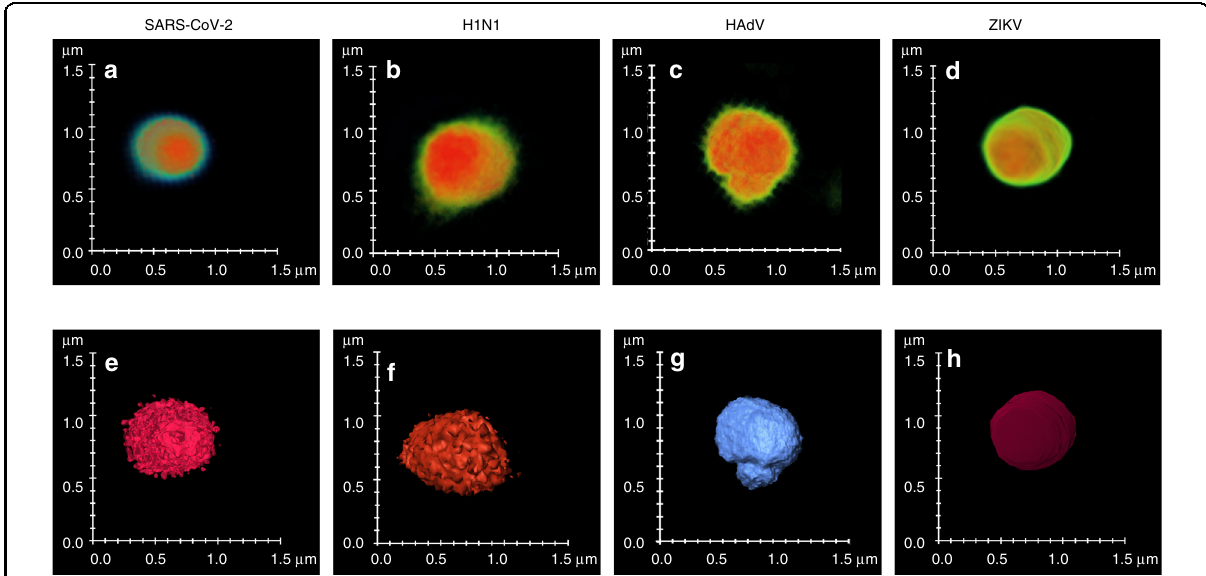
Fig. 4 3D tomograms. Volume reconstruction of a SARS-CoV-2. b H1N1. c HAdV. d ZIKV. Surface reconstructions of e SARS-CoV-2. f H1N1. g HAdV. h ZIKV. All reconstructions were performed using the Amira software. Scalebars are representative of lateral dimensions of the respective